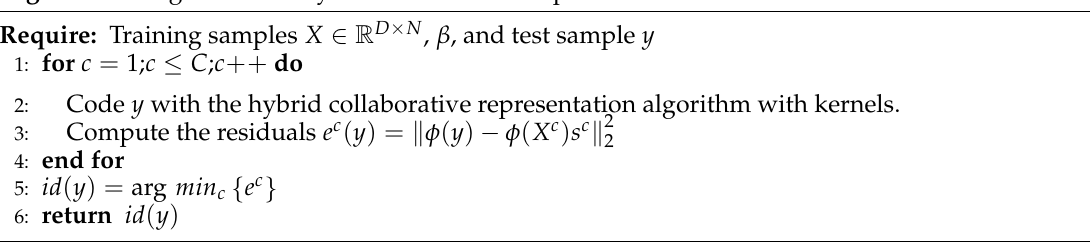
Algorithm 1 Algorithm for hybrid collaborative representation-based classification with